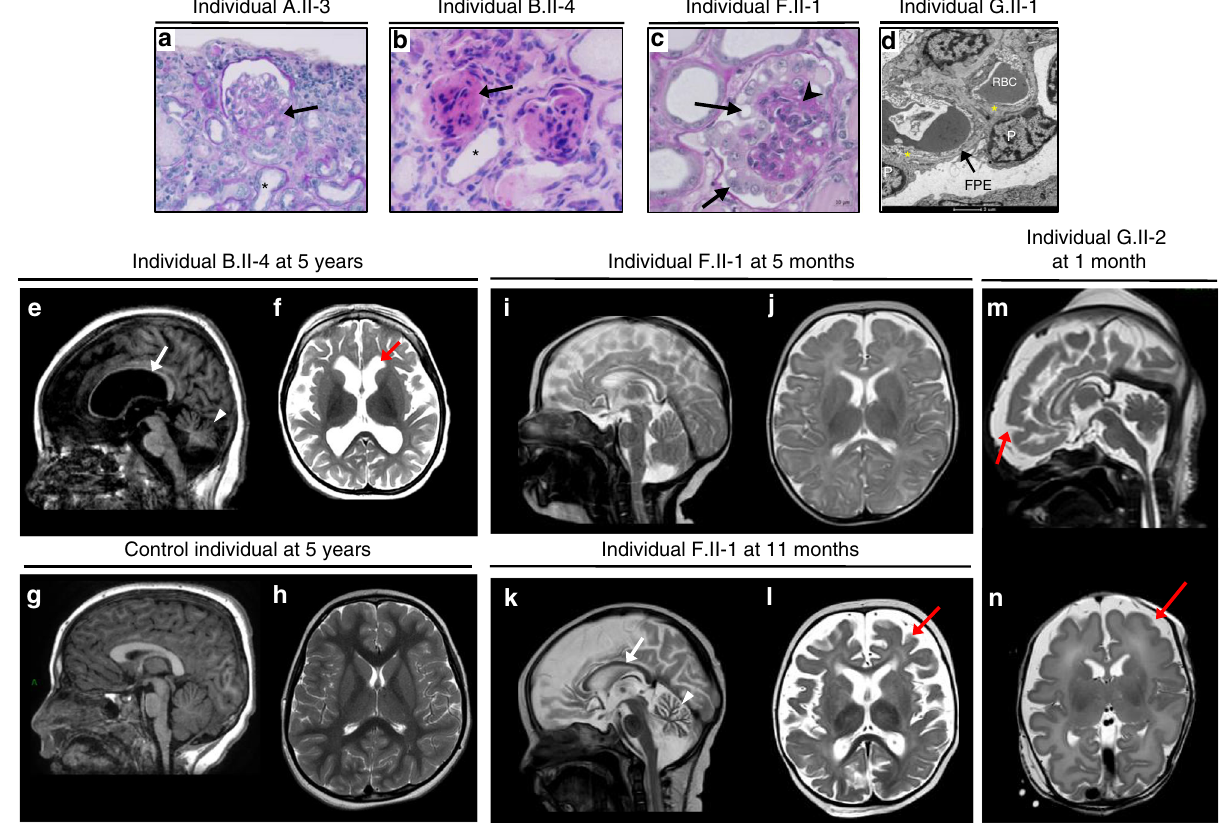
Fig. 2 Kidney pathology analysis and neuroimaging. Light and transmission electron microscopy (TEM) of kidney sections of patients with GON7 ( a , b ) or YRDC mutations ( c , d ). a Individual A.II-3 displays a retracted glomerulus with a focal segmental glomerulosclerosis lesion at the vascular pole (black arrow) and tubular dilations (black star) (PAS; ×200 magni fi cation). b Individual B.II-4 displays diffuse mesangial sclerosis with tiny, retracted and sclerosed glomeruli (black arrow) with dilated tubes surrounded by fl at epithelial cells (black star) and interstitial fi brosis (H&E; ×400 magni fi cation). c Individual F.II-1 displays a marked glomerular tuft collapsing (arrowhead) surrounded by a layer of enlarged and vacuolized podocytes (black arrows) (PAS stain; ×400 magni fi cation, scale bar, 10 µ m). d TEM of individual G.II-1 shows diffuse foot process effacement (FPE; black arrow), a classical hallmark of nephrotic syndrome, along a glomerular basement membrane (GBM) with abnormal folded and laminated segments (yellow stars), alternating with others with normal appearance. P podocyte, RBC red blood cell. Scale bar, 2 µ m. Brain MRI of patients with GON7 ( e , f ) and YRDC mutations ( i – n ). e , f